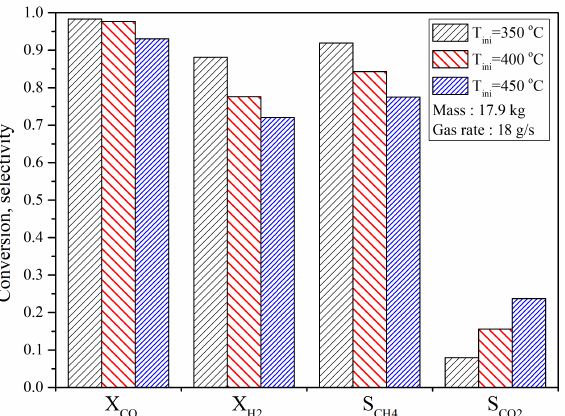
Figure 15. Profile of conversion and selectivity under different initial